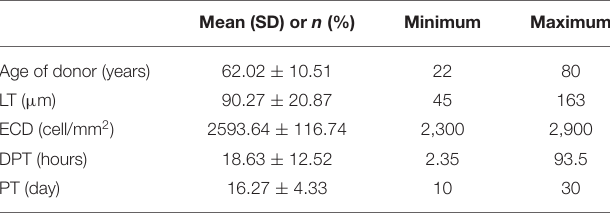
TABLE 2 | Details of graft used in this